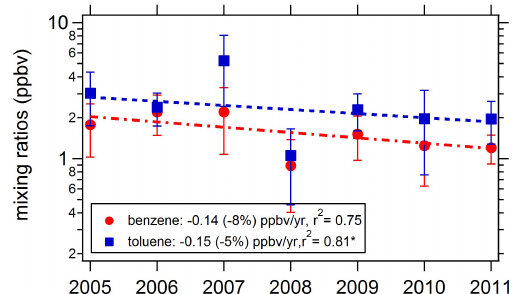
Figure 9. Variations in the daytime averages of benzene (red dots) and toluene (blue squares) mixing ratios in Beijing, August between 2005 and